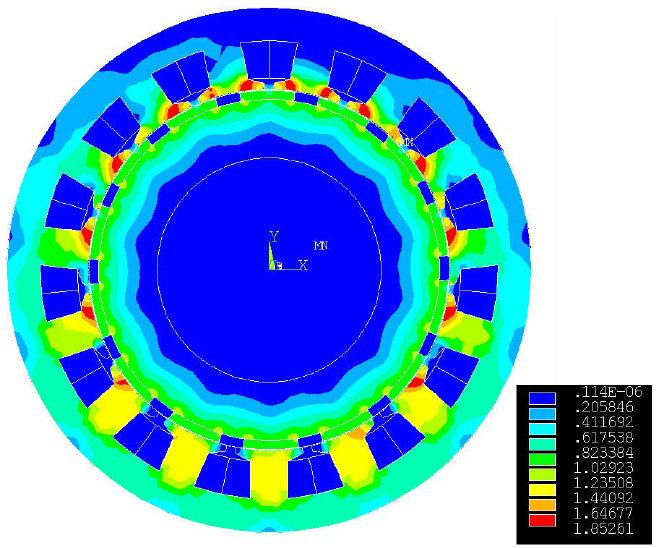
Figure 11. Flux density mapping under no-load operation.